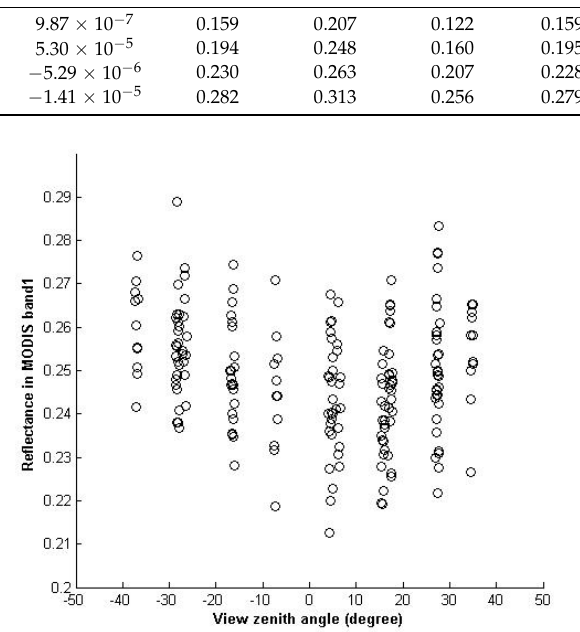
Table 7. The statistics from the time series of the TOA reflectance of MODIS from both Terra and Aqua. Sensor Band Slope Intercept Maximum Minimum Mean Standard Deviation Terra/MODIS Aqua/MODIS